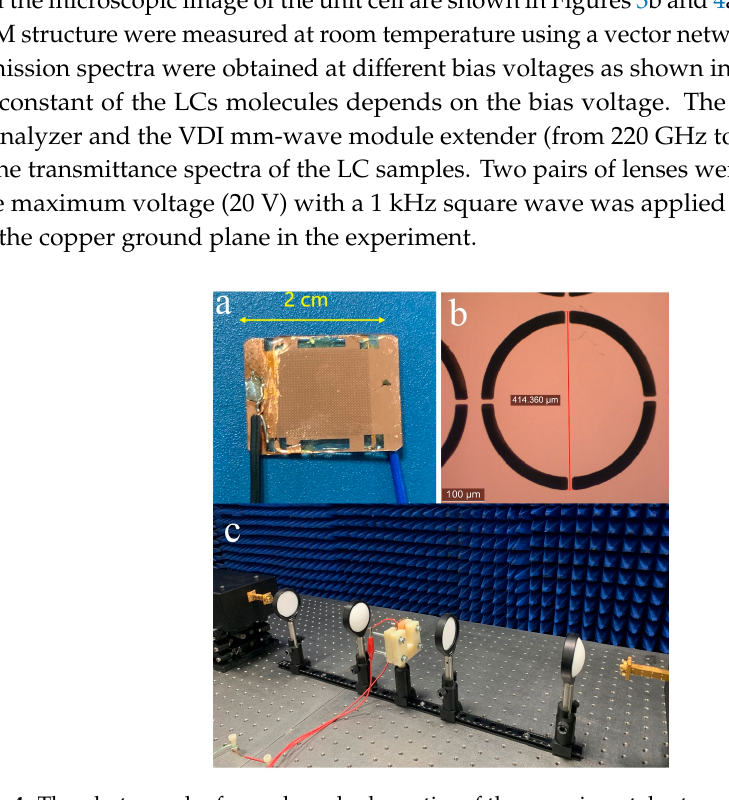
Figure 4. The photograph of sample and schematics of the experimental setup. ( a ) Fabricated sample structure (20 × 20 mm 2 ). ( b ) A polarized microscope image of a single unit cell. ( c ) Experimental measurement setup.